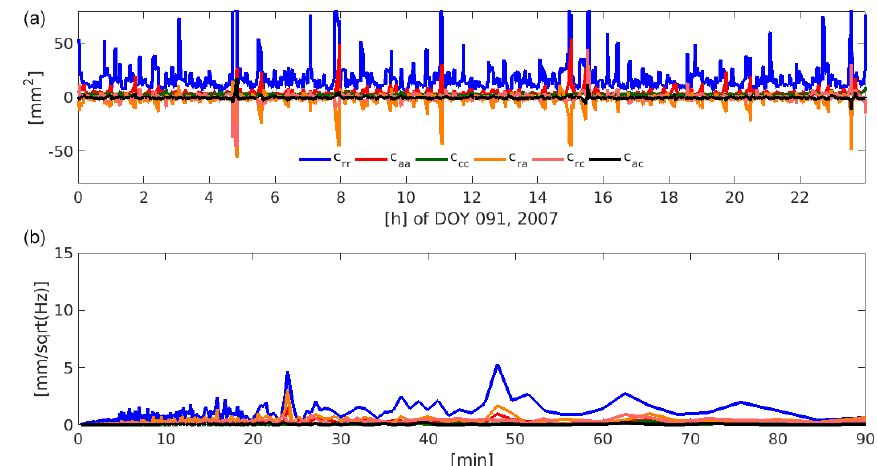
Figure 1. Independent components of the epoch-wise covariance matrix of GRACE-A for one arc, day 091, 2007, in radial (r), along-track (a) and cross-track (c) direction in the time (a) and frequency (b) domain. The amplitude spectrum in the bottom graph shows a clear peak at 48min corresponding to half of the orbital period.